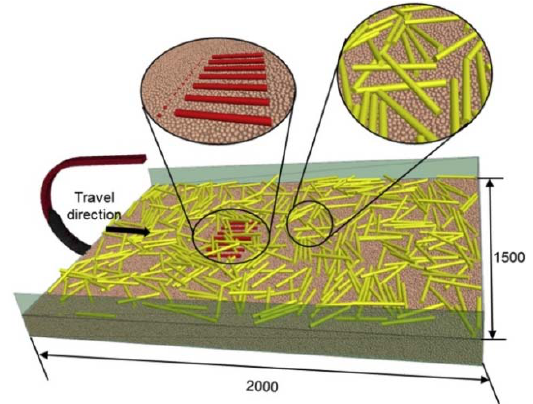
Figure 5. The soil-tool-residue interaction model (Zeng et al., 2020).